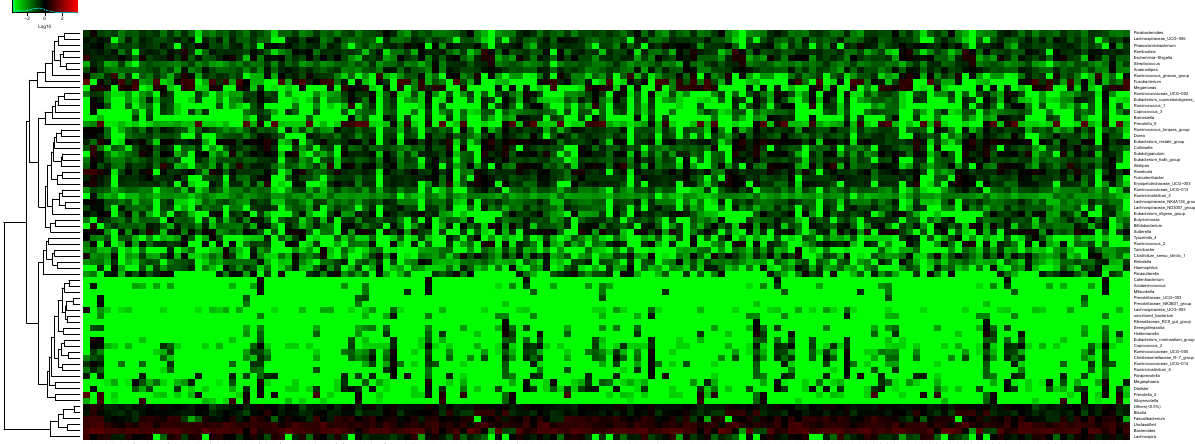
Figure 2. Heatmap of 48 stool samples at the genus level. Stool samples demonstrate the high relative abundance of Bacteroides, Faecalibacterium, Blautia, Blautia, and Lachnospira(relative abundance ≥ 0.5% were annotated, < 0.5% were classified as